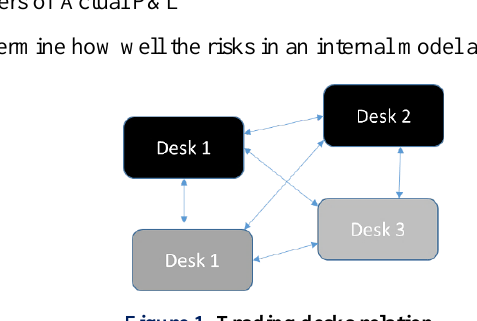
Figure 1. Trading desks relation.